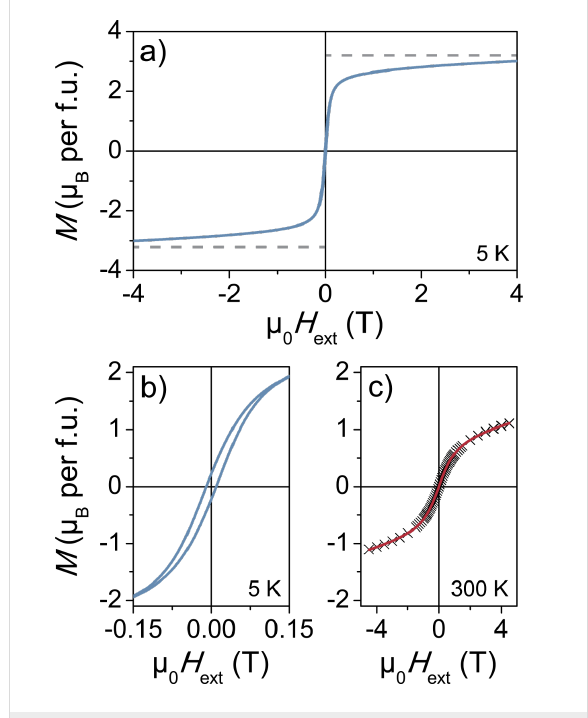
Figure 7: Field-dependent SQUID magnetometry of as-prepared ZFO nanoparticles at (a,b) 5 K and (c) 300 K. The dashed lines in (a) indi- cate the theoretical saturation magnetization. The red line in (c) is the best Langevin model fit to the data.